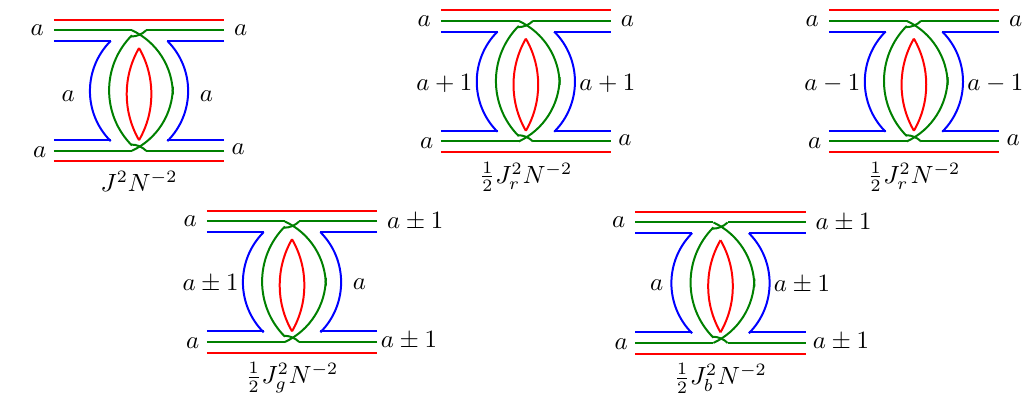
Figure 13. Contribution of interactions to